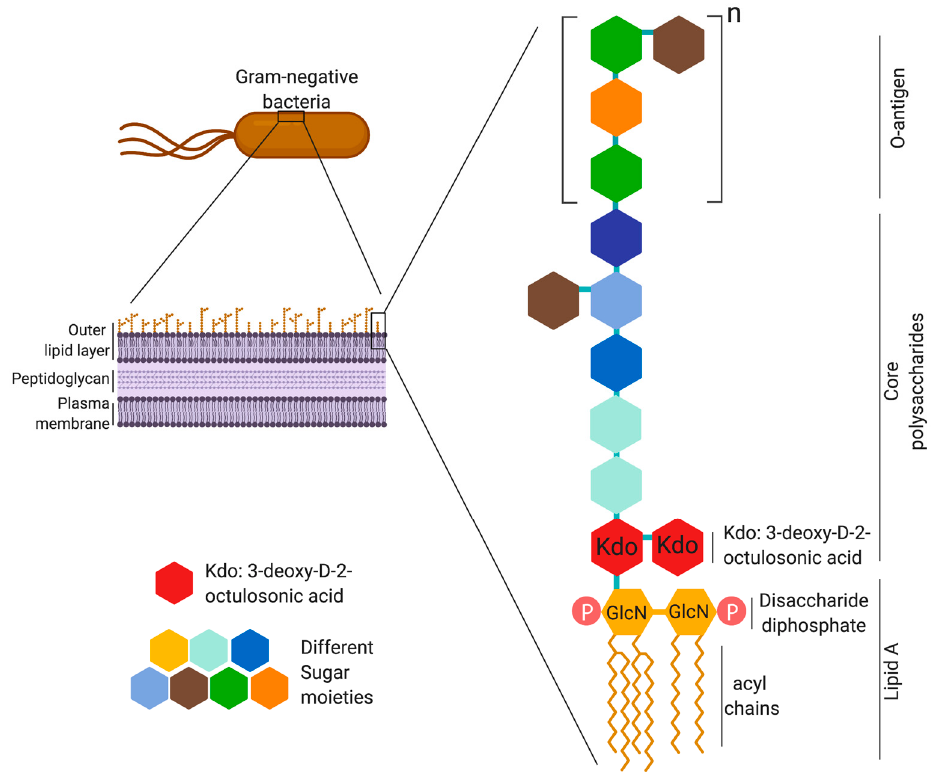
Figure 1. Structural details of lipopolysaccharide from a Gram-negative bacterium. Lipopolysaccharide (LPS) provides structural and functional integrity to outer membrane of Gram-negative bacteria. LPS is an amphipathic molecule with a general structure consisting of three different regions: hydrophobic lipid A, core polysaccharide, and O-antigen (repeats of polysaccharide chain, where n can be up to 40 repeats). Lipid A consist of bisphosphorylated diglucosamine backbone substituted with six acyl chains that are attached by ester or amide linkage.